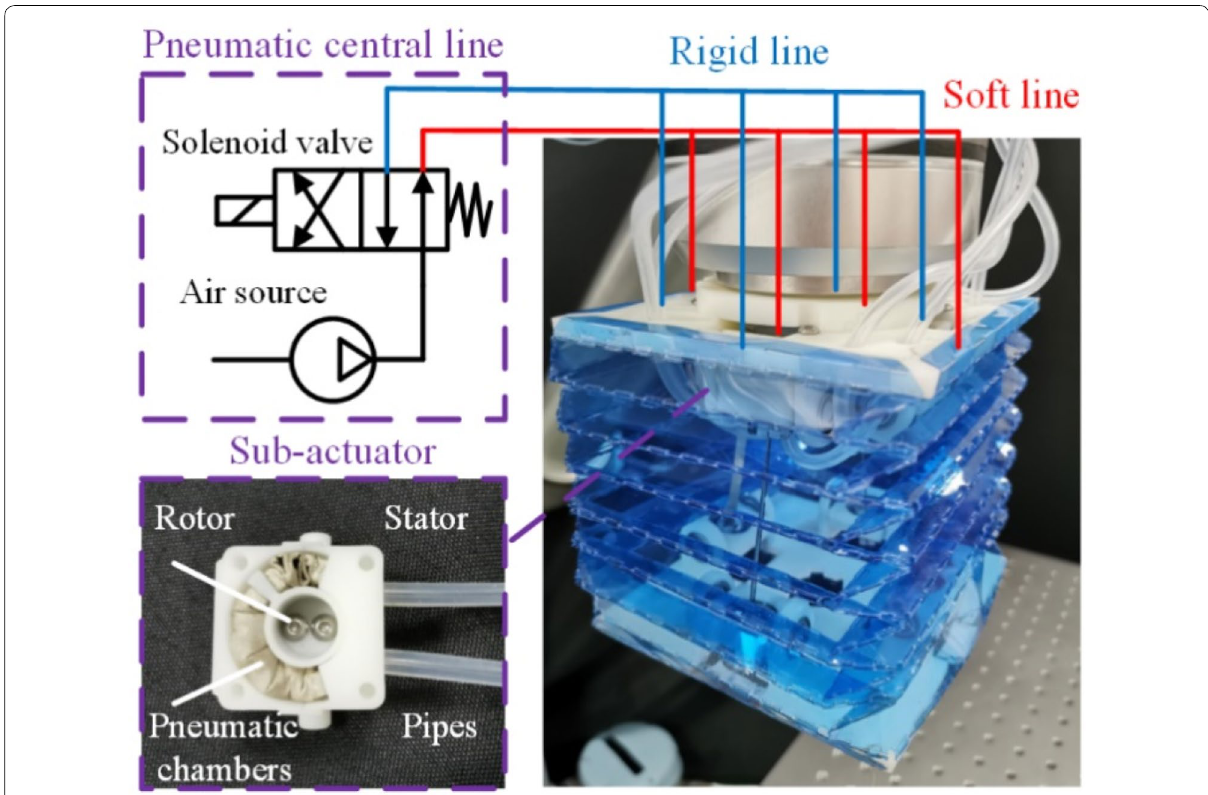
Figure 5 Si-Mo pneumatic actuation